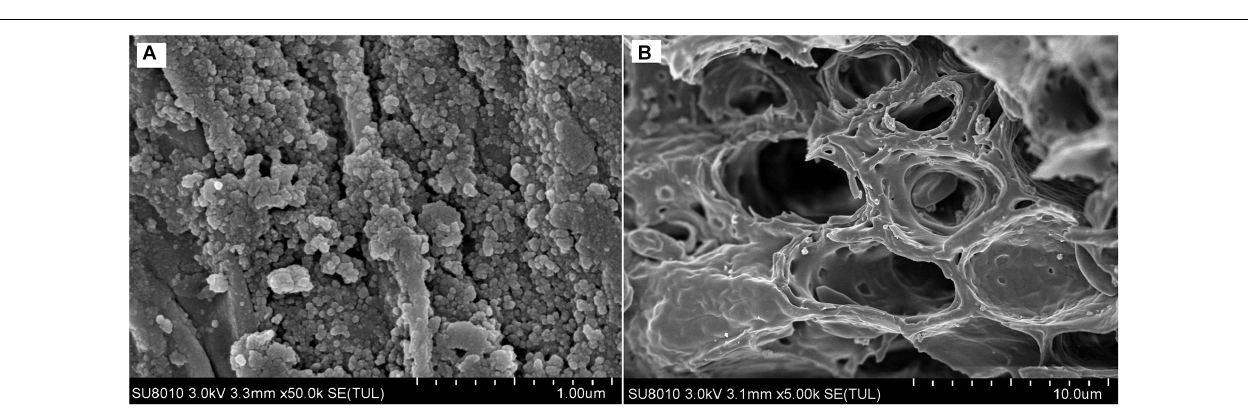
FIGURE 2 | Scanning Electron Microscopy (SEM) of biochar particles and Cordyceps fumosorosea -Biochar nanoparticles. (A) 1.00 micrometer; (B) 10.0